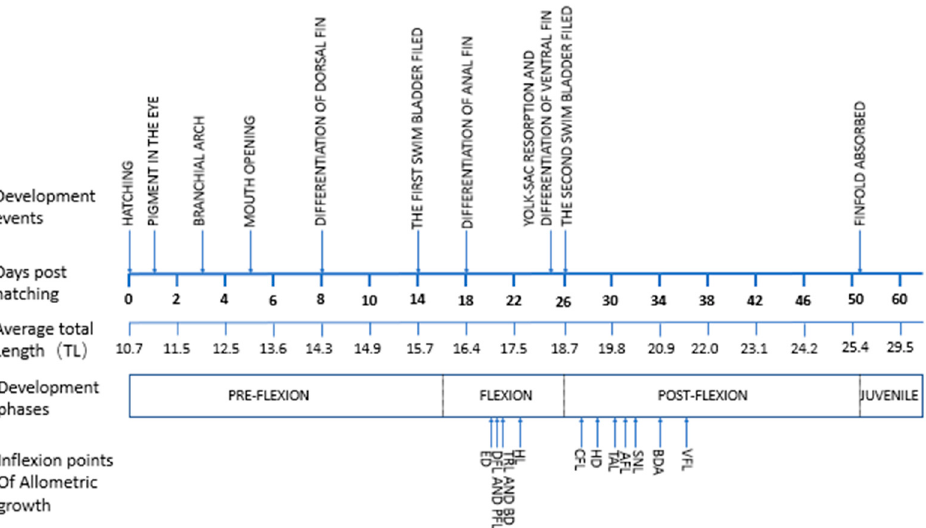
Figure 7. Major growth events of P. retrodorslis during larval and juvenile periods. AFL, anal fin length; BD, body depth; BDA, body depth at anus level; CFL, caudal fin length; DFL, dorsal fin length; HL, head length; HD, head depth; ED, eye diameter; PFL, pectoral fin length; SNL, snout length; TAL, tail length; TRL, trunk length; TL, total length; VFL, ventral fin